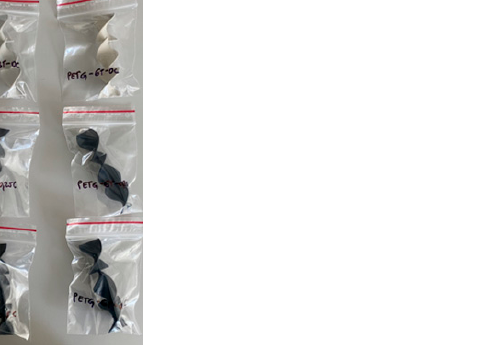
Figure 1. PETG static mixer in Helix form ( left ); Static mixers with different contents of TiO 2 /CNTs ( right ).